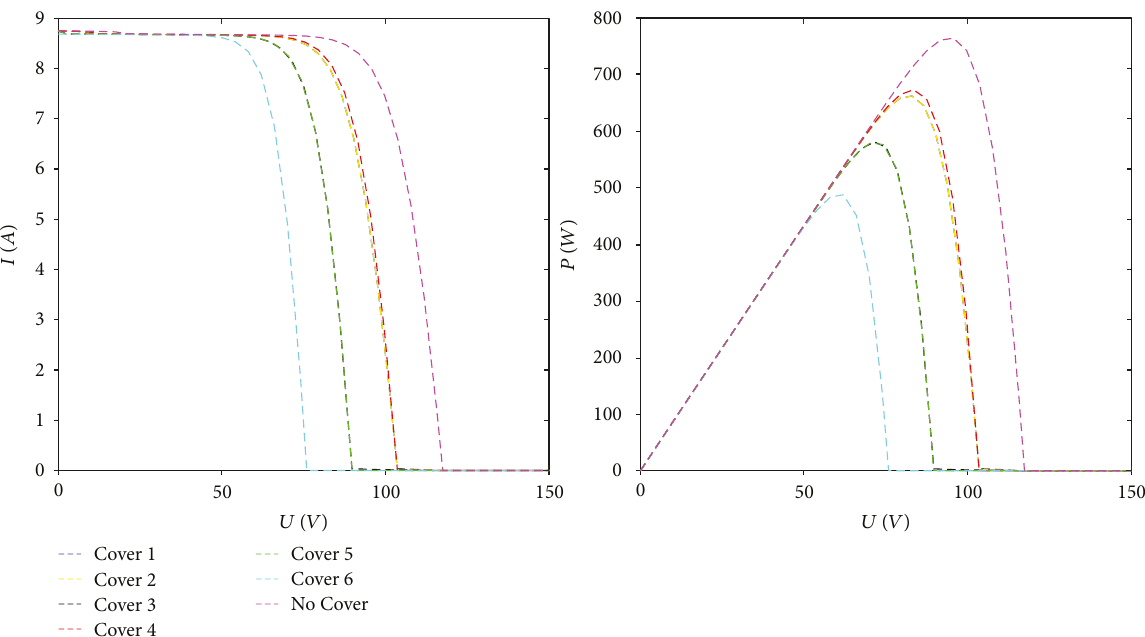
Figure 9: Simulation result for cover shading. The output curve without multipeak feature under cover shading.